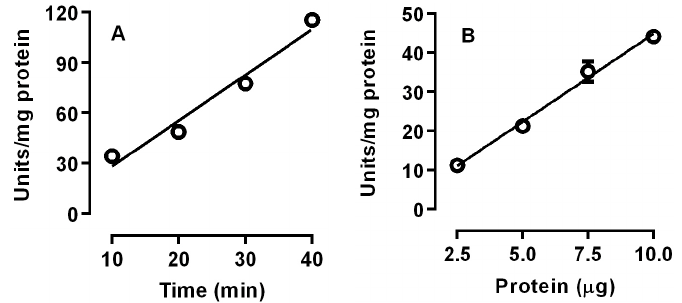
Figure 1. Time course ( A ) and the effects of the enzyme concentrations ( B ) on the lipase activity of the posterior midgut homogenate (crude extract) of R. palmarum larvae. The error bars represent the standard deviation (SD) for three determinations.